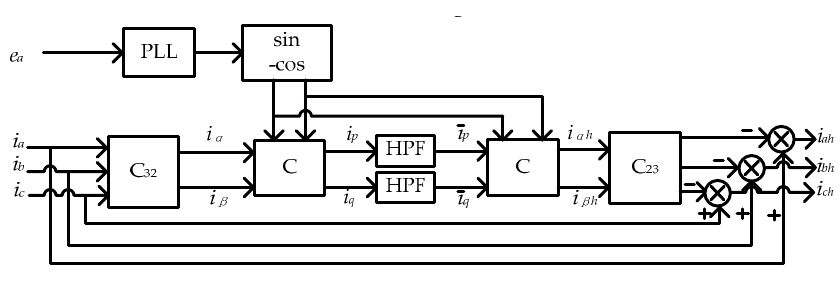
Figure 3. i p -i q Figure 3. i p -i q calculation.